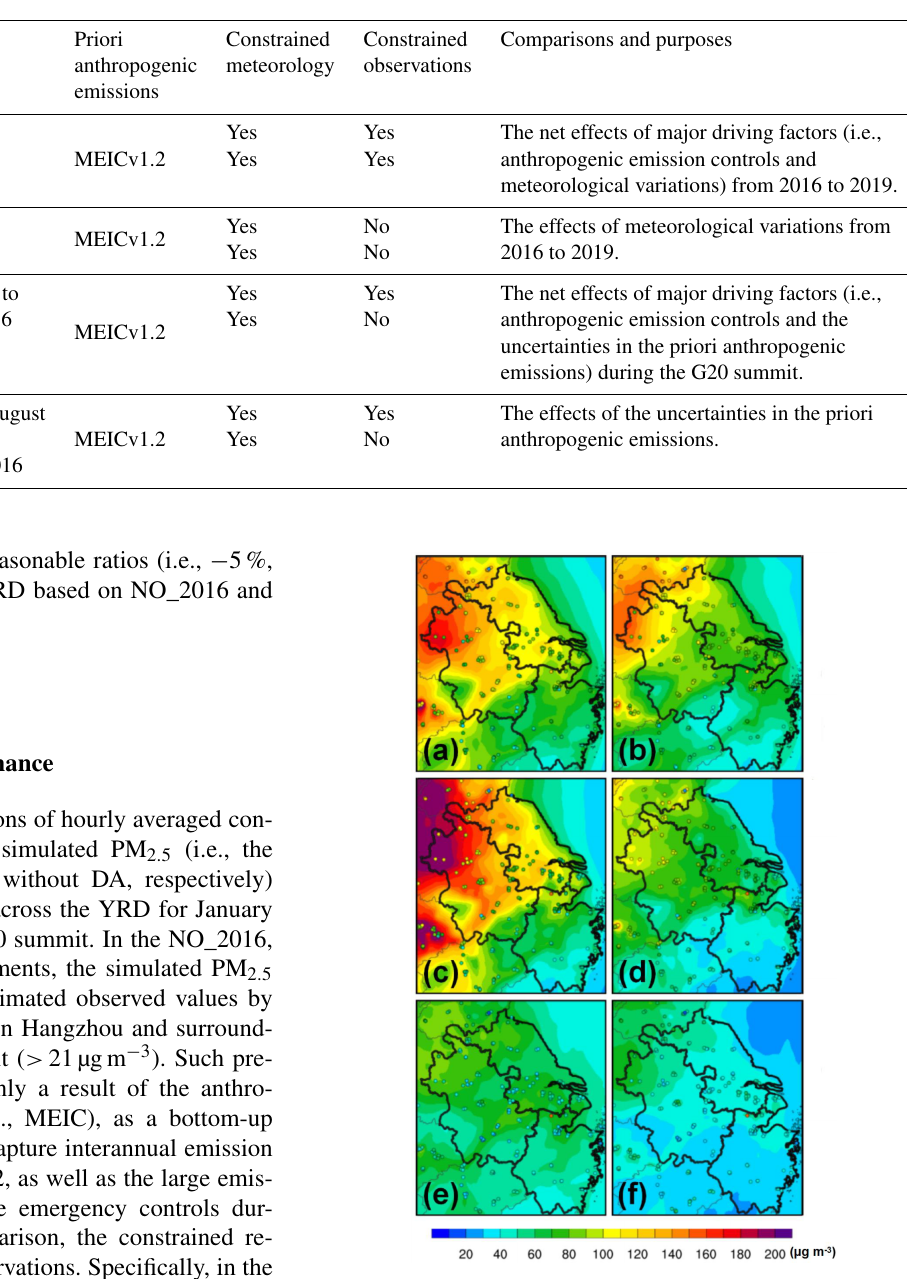
Figure 3. Spatial comparisons of hourly-averaged concentrations of simulated and constrained PM 2 . 5 with surface observations across the YRD for January 2016 (a, b) , January 2019 (c, d) , and the G20 summit (e, f) : (a) NO_2016; (b) DA_2016; (c) NO_2019; (d) DA_2019; (e) NO_G20; (f) DA_G20. Circles denote ground measurement